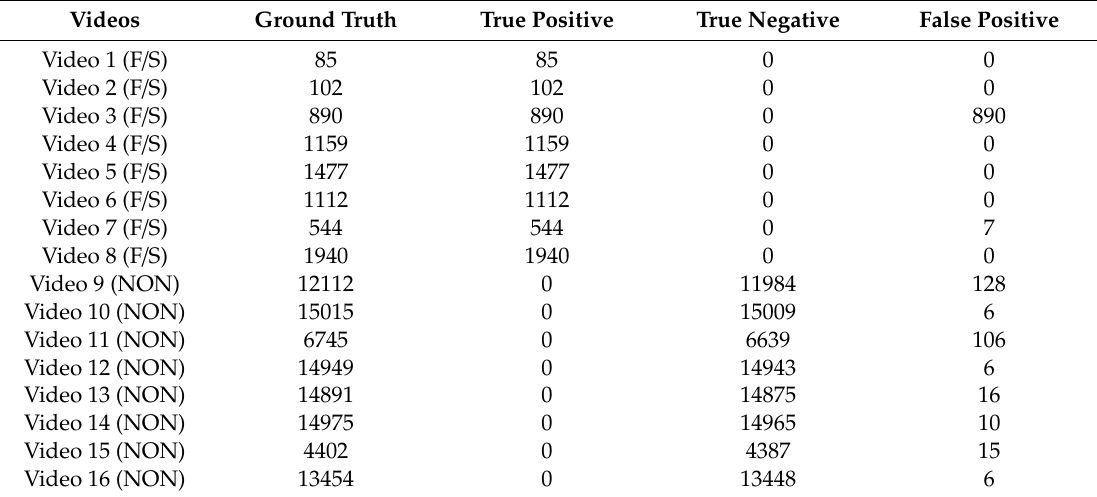
Table 1. The results of video test using general Faster R-CNN